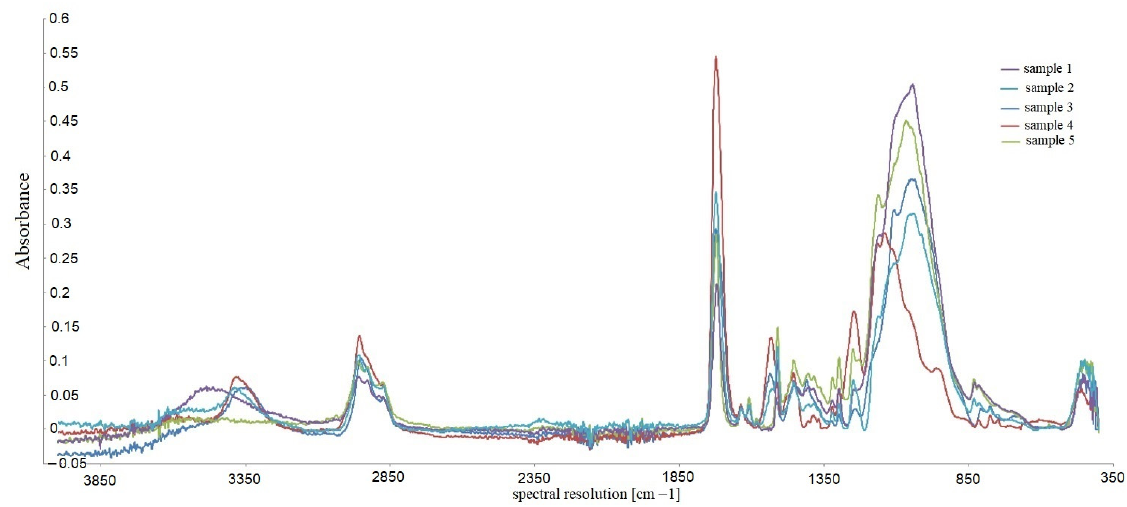
Figure 10. Cumulative IR spectra.